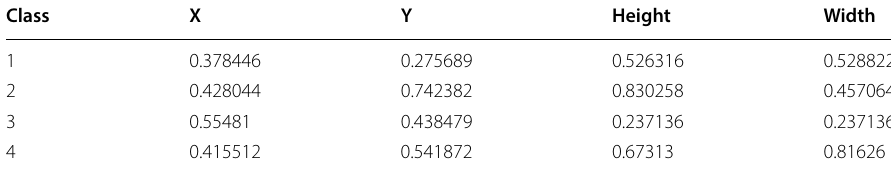
Table 1 Sample bounding box values for different image